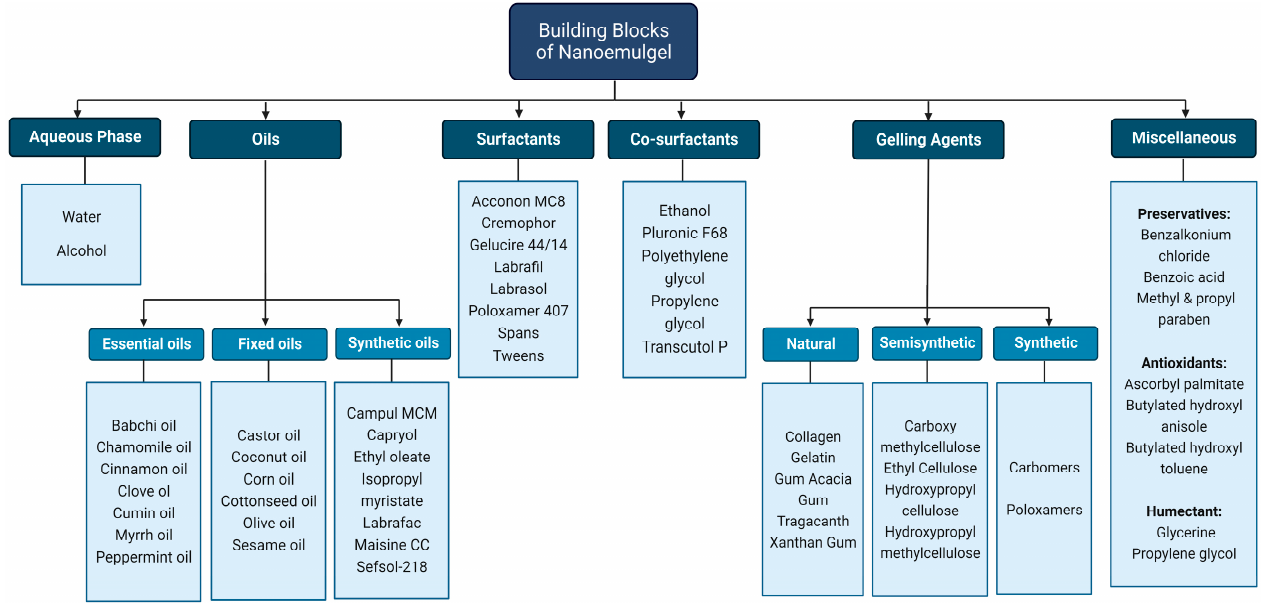
Figure 3. Concept diagram for the building blocks required to design an NEG .